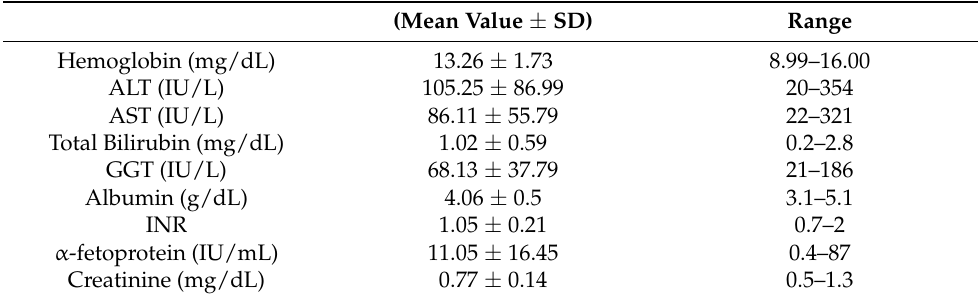
Table 3. Patients’ biochemical status (BSL).